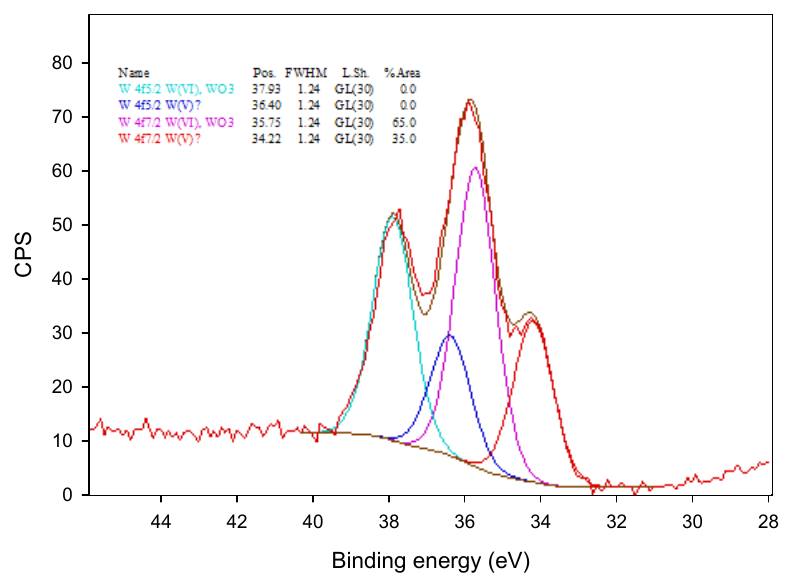
Figure 5. The XPS spectrum of the tungsto-phosphate